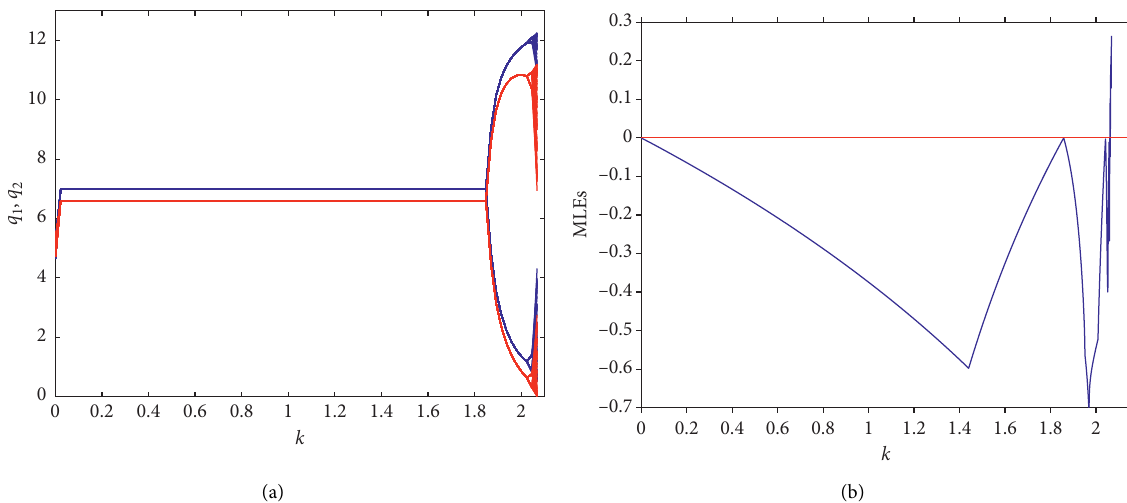
Figure 1: Bifurcation diagram and MLEs for game (12) with respect to control parameter k at a � 6 , b � 0 . 3 , c